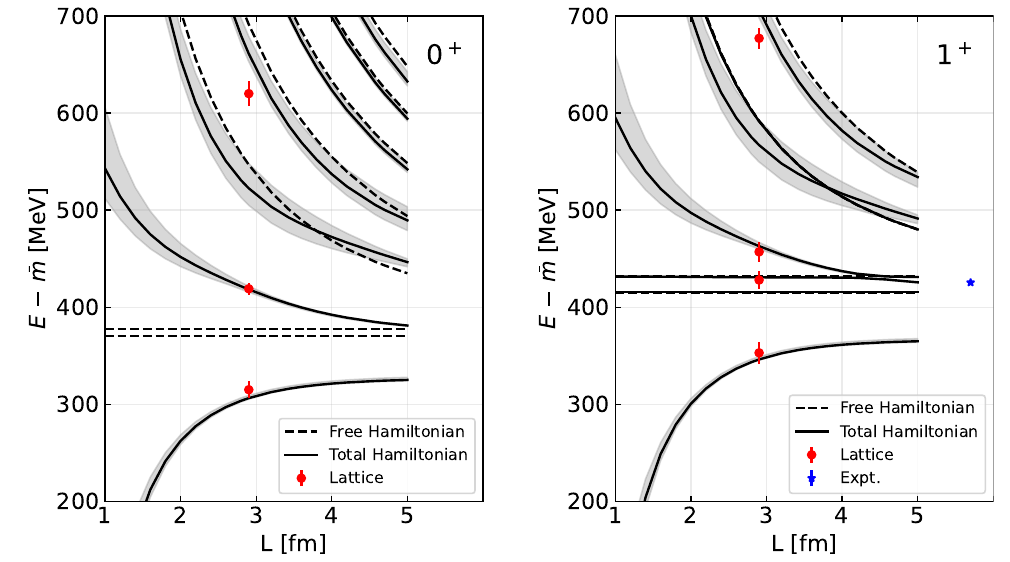
Figure 3 . The comparison of the predicted energy levels for the B ∗ with lattice simulation. The ¯ m is defined as 1 error bar are the lattice energy levels from ref. [93], while the blue star is the experimental mass of B ∗0 . The black curves and the dashed lines are the predictions in a finite volume with and without s 1 interacting Hamiltonian,